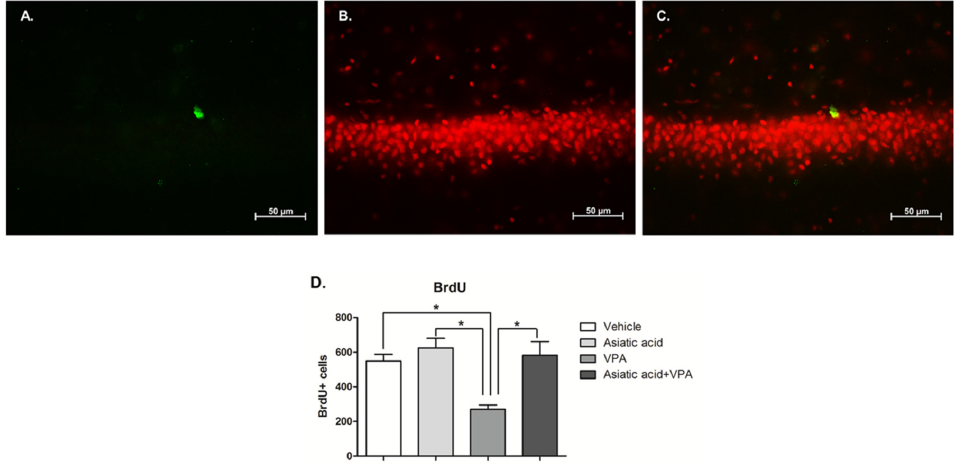
Figure 4. The number of BrdU positive cells in the SGZ of the hippocampal dentate gyrus. BrdU positive cells were stained in the SGZ of the dentate gyrus (green; ( A )). Nuclei were counterstained with propidium iodide (red; ( B ) and figure merged ( C )). BrdU positive cell number in VPA ‐ treated group was significantly lower than vehicle, Asiatic acid and Asiatic acid plus VPA groups (* p < 0.05). One ‐ way ANOVA with LSD post hoc test was used to compare between all groups ( D ).